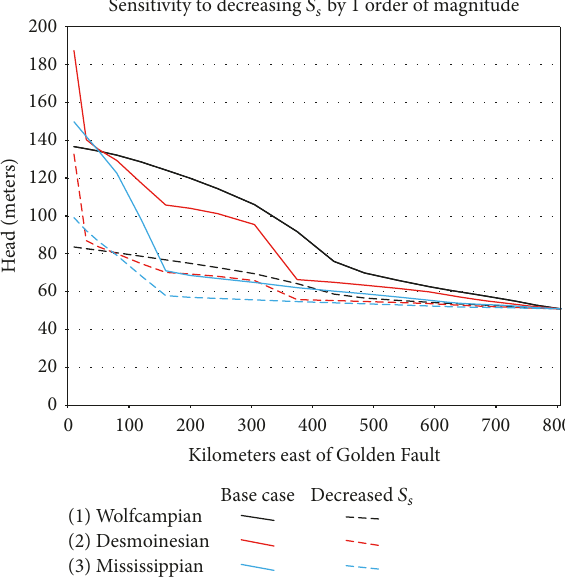
Figure 26: Sensitivity to decreasing 𝑆 𝑠 by an order of magnitude.